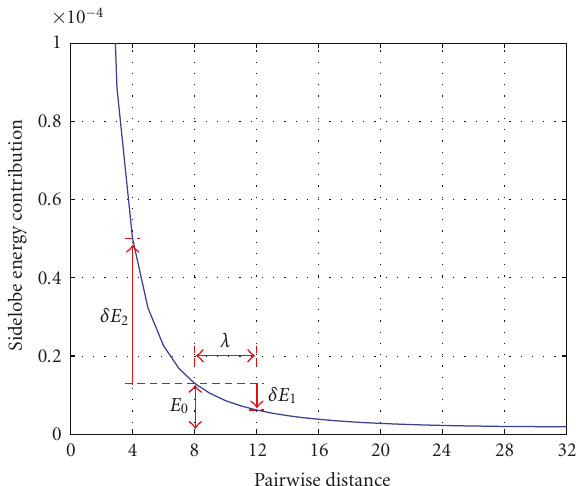
Figure 3: Relation between pairwise pilot distance and aperiodic ACF sidelobe energy contribution for N = 64.